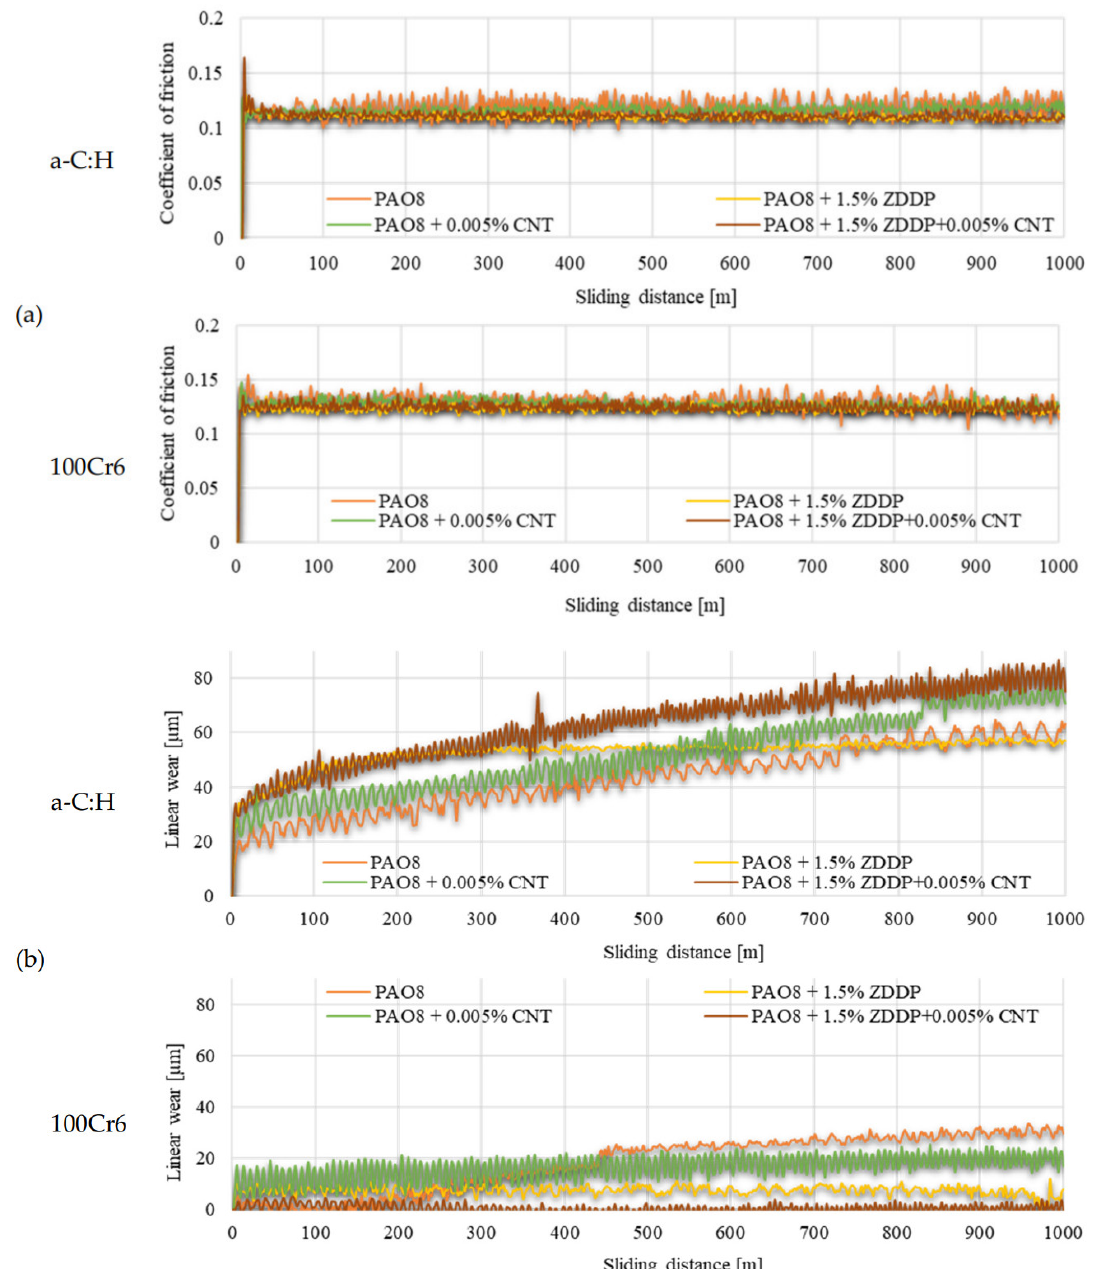
Figure 4. ( a ) Coefficient of friction vs. sliding distance, and ( b ) linear wear vs. sliding distance. Figure 4. ( a ) Coe ffi cient of friction vs. sliding distance, and ( b ) linear wear vs. sliding